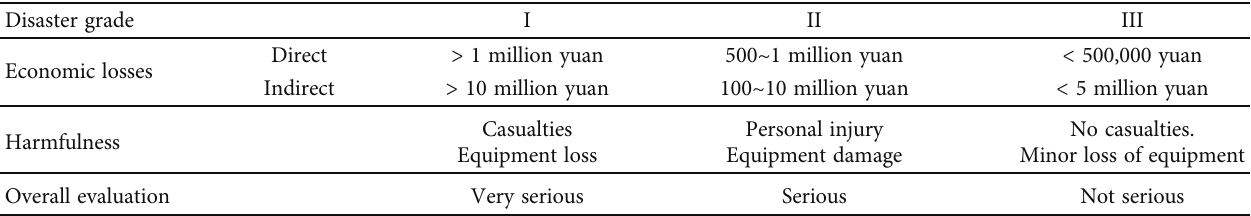
Table 10: Grade of slope disaster.